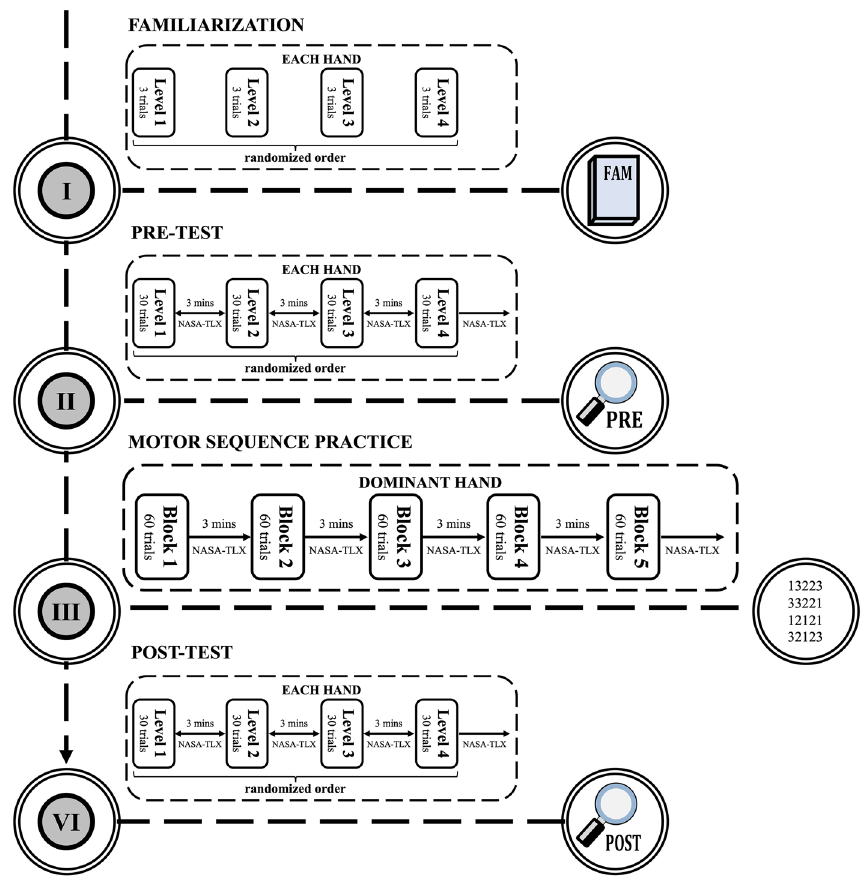
Figure 1. Schematic illustration of the experimental procedures. Participants performed a familiarization of each sequence complexity with each hand before the start of testing. Participants were instructed to perform finger key presses in response to numeric sequences presented on the screen with both their right and left hand in a randomized order. The test consisted of 4 blocks of 30 trials with different sequence complexity. After the pre-test, participants performed the motor sequence practice with their dominant hand. The practice was divided into 5 blocks of 60 trials. Immediately after the practice, participants performed the post-test, which consisted of the same set of sequences in each block as the pre-test, however, the order of appearance was randomized. The NASA-TLX was administered at the end of each block of both testing and practice. Images within the figure were drawn by János Négyesi using Microsoft Office Power Point 2018 software (Microsoft, Redmond, Washington,